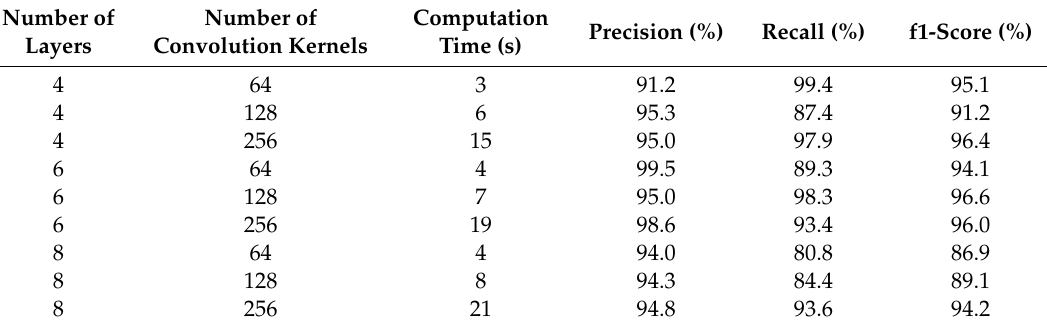
Table 4. Parameter settings of the convolutional neural network (CNN).